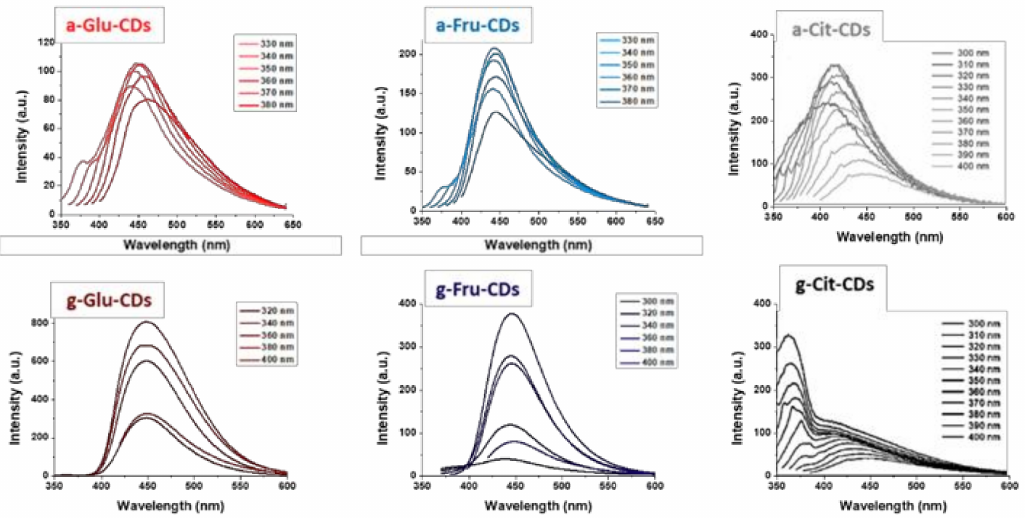
Figure 4. Photoluminescence (PL) spectra of amorphous and graphitic